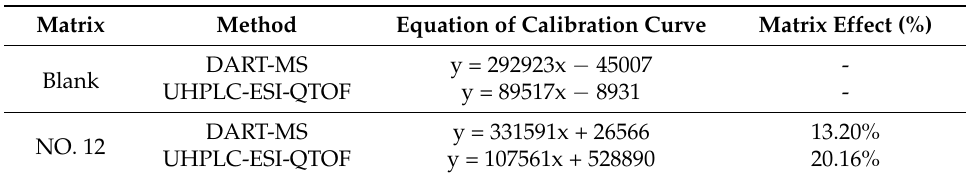
Table 3. Matrix effects of the No.12 variety by DART-MS versus UHPLC-ESI-QTOF method. Matrix